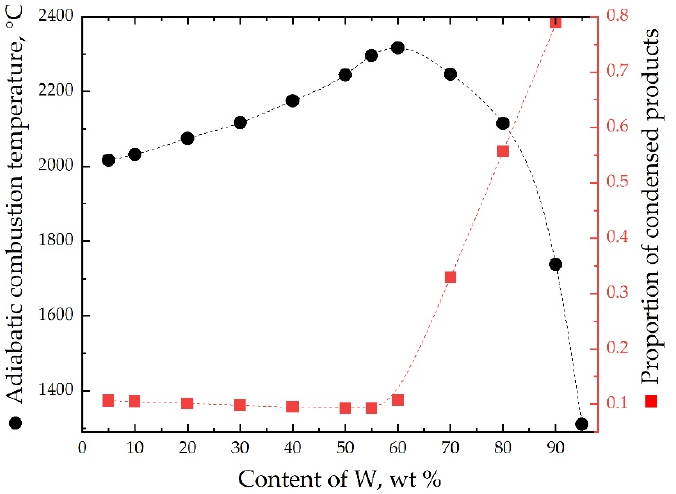
Figure 5. Adiabatic combustion temperature and the proportion of condensed products in the W/PTFE system.